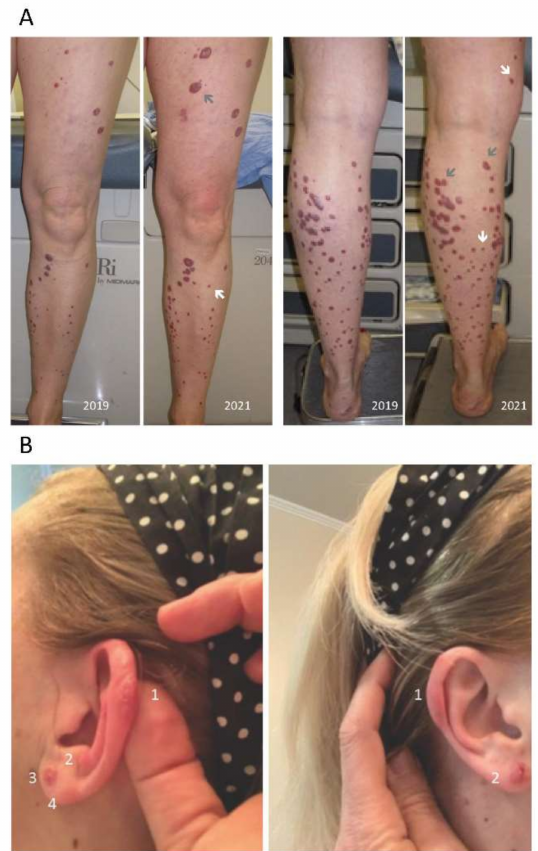
Figure 1. Clinical features. ( A ) Upper panels show the patient’s legs, in frontal and posterior views, in 2019 and 2021. One subungual lesion occurred (not shown). The leg lesions showed progression over 2 years, with some new lesions (white arrows) and some growing lesions (grey arrows). ( B ) Lower panels show the patient’s ears in 2021. Multiple lesions occurred on both ears (left, 4 lesions; right, 2 lesions, clearly